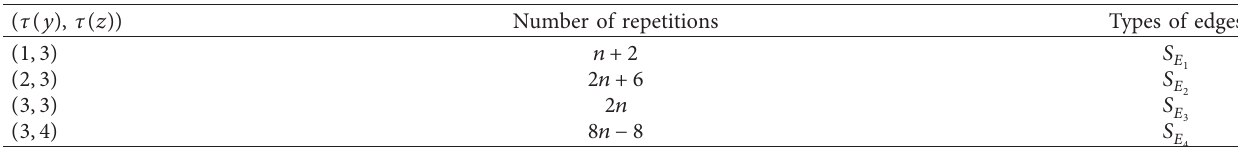
Figure 2: (a) Unit cell. (b) Generalized structure of GST − SL [ n ] . Table 2: Edge partition of GST − SL [ n ]